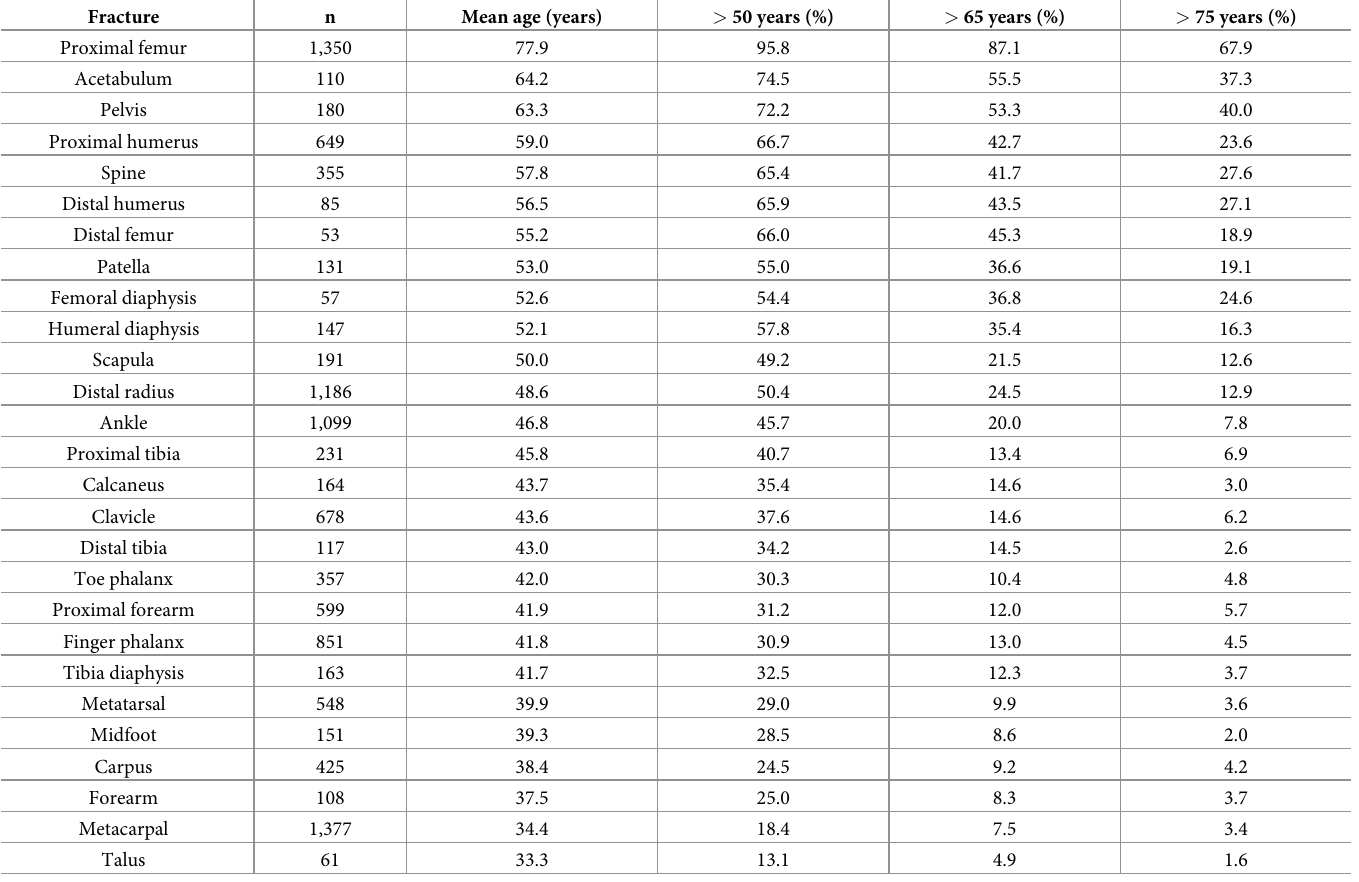
Table 4. Numbers of all fractures occurring in men, arranged in order of decreasing mean age, and with proportion of each of the fracture types in patients over 50, 65, and 75 years of age. Fracture